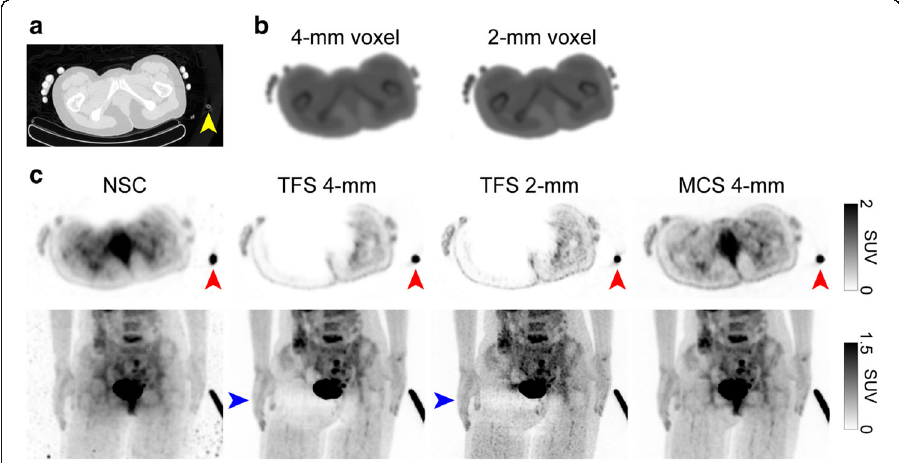
Fig. 2 Representative PET images of a patient (urine shift pattern). CT image ( a ), 4-mm and 2-mm voxel μ - maps ( b ), PET images with non-scatter-correction (NSC), TFS 4-mm, TFS 2-mm, and MCS 4-mm ( c ). Yellow arrow : urinary catheter. Red arrows : urine in the urinary catheter. Blue arrows: halo